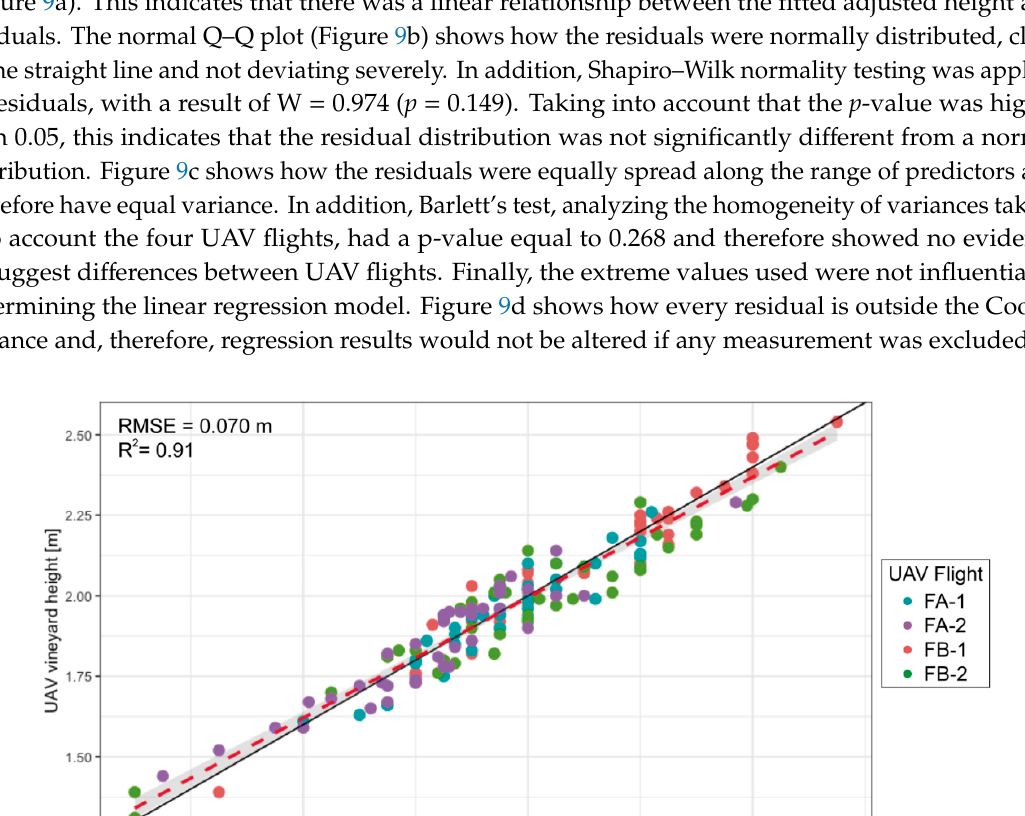
Table 4. F and p-values of the two-way ANOVA for vine height error.